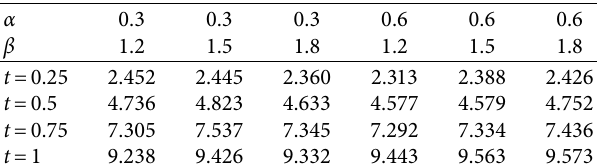
Table 3: Computation time (CPU time in s) needed for solving FCNLSE (32) with initial conditions (35) via the two-step ETD scheme (18) utilizing the Pad´e approximation (24), taking h � 0 . 05 and τ � 0 .